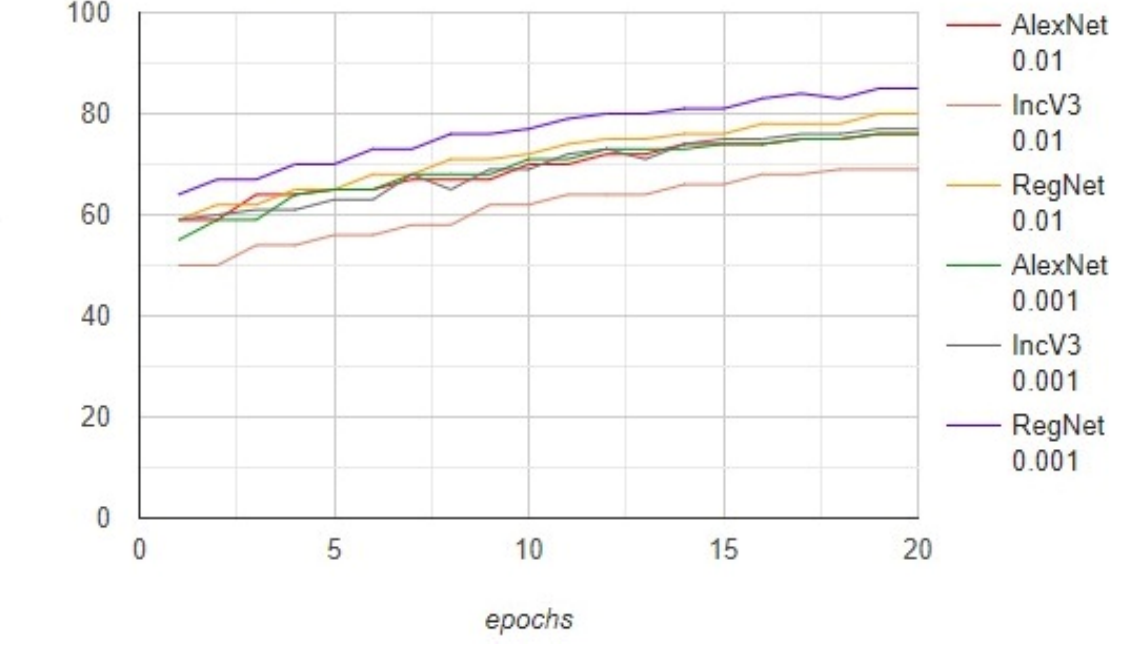
Figure 5. The comparison between the AlexNet, InceptionV3, and RegNetY-320 models on the imbalanced dataset.